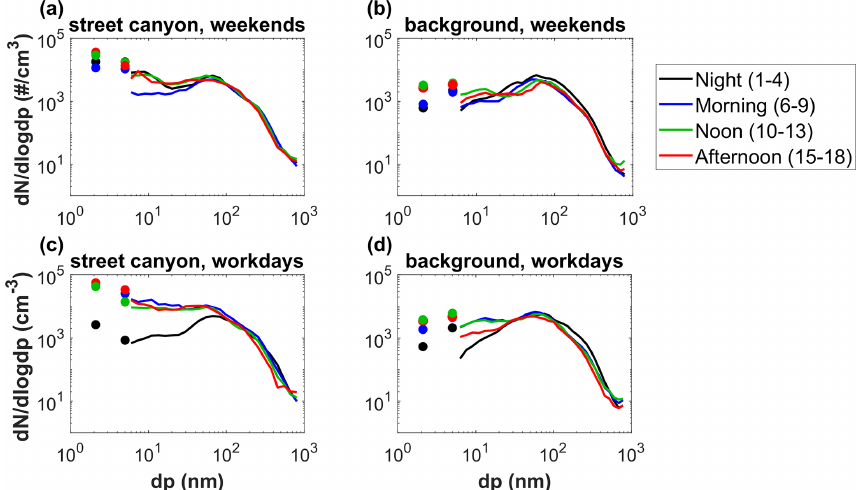
Figure 2. Median particle size distribution (a, c) at the street canyon and (b, d) at the background station. The colors indicate different periods of the day: night (01:00–4:00LT, black), morning (06:00–09:00LT, blue), noon (10:00–13:00LT, green), and afternoon (15:00–18:00, red). The top row presents size distribution measured during weekends (a, b) and the bottom during workdays (c, d) . Median size distribution was determined by DMPS (particles with sizes between 6–800nm) marked with solid lines in the figure, UCPC and CPC (3–7nm), and PSM and UCPC (1–3nm) marked with dots. This figure with a linear y axis can be found in Fig. S3. Table 2. NPF event classification at the background station for the period 27 April–5 June 2018. Results are presented separately for a full campaign, weekends, and